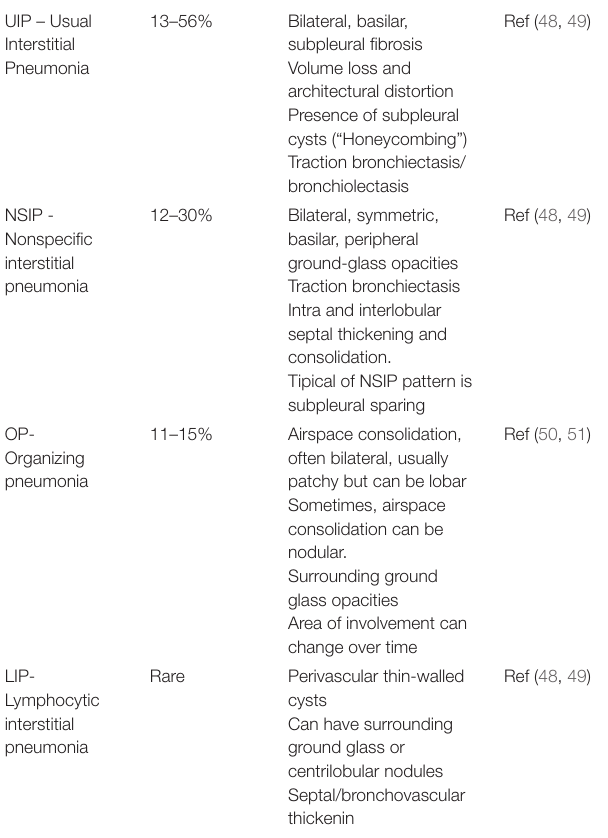
TABLE 2 | HRCT findings of Interstitial Lung Disease in RA